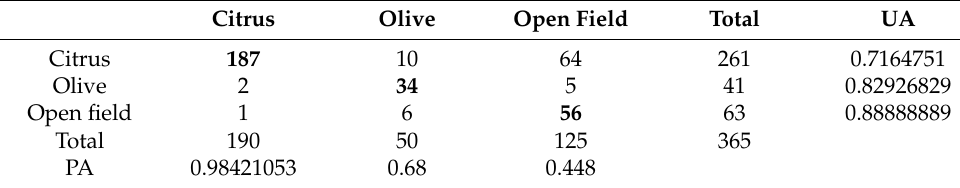
Table 4. Confusion matrix of the classification with NDVI as the input feature performed by M10. Citrus Olive Open Field Total UA 187